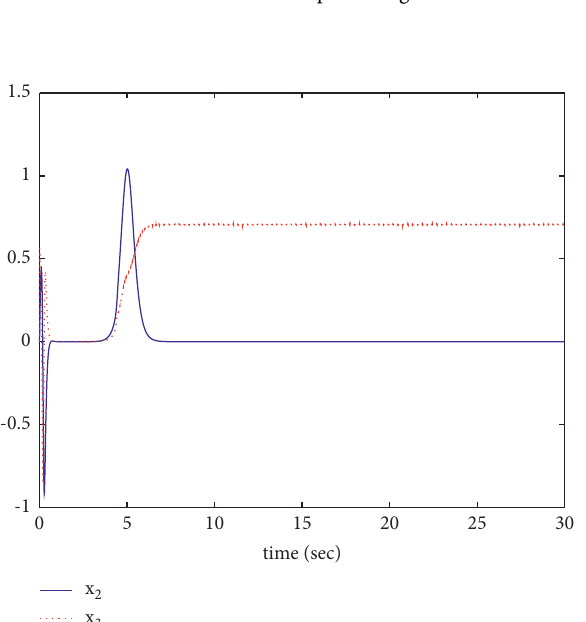
Figure 14: The input voltage.